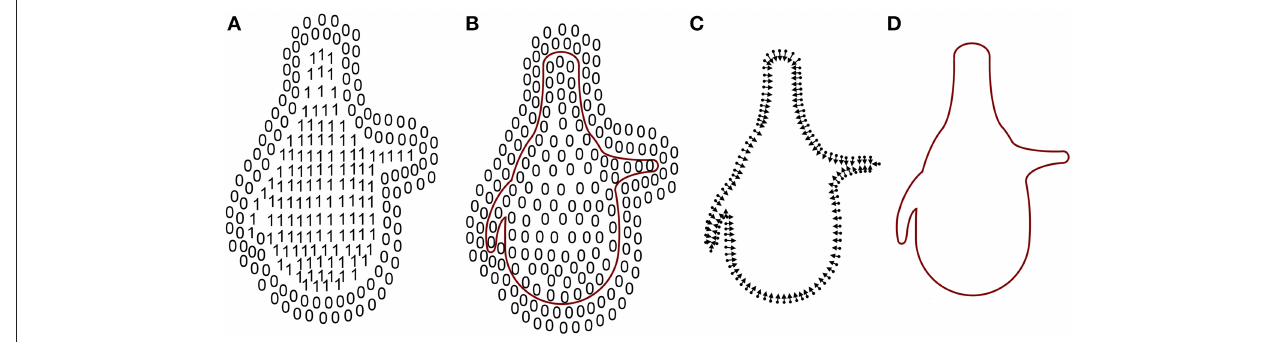
FIGURE 4 | Mesh reconstruction. (A) The indicator function. (B) Inward-facing normals and their vertices. (C) Gradient of the indicator function. Since the indicator function is constant outside (0s) and inside (1s) the mesh, the gradient of the space there is 0. Only points on the frontier are not 0. (D) Surface of the mesh. Adapted from Kazhdan et al. (2006).